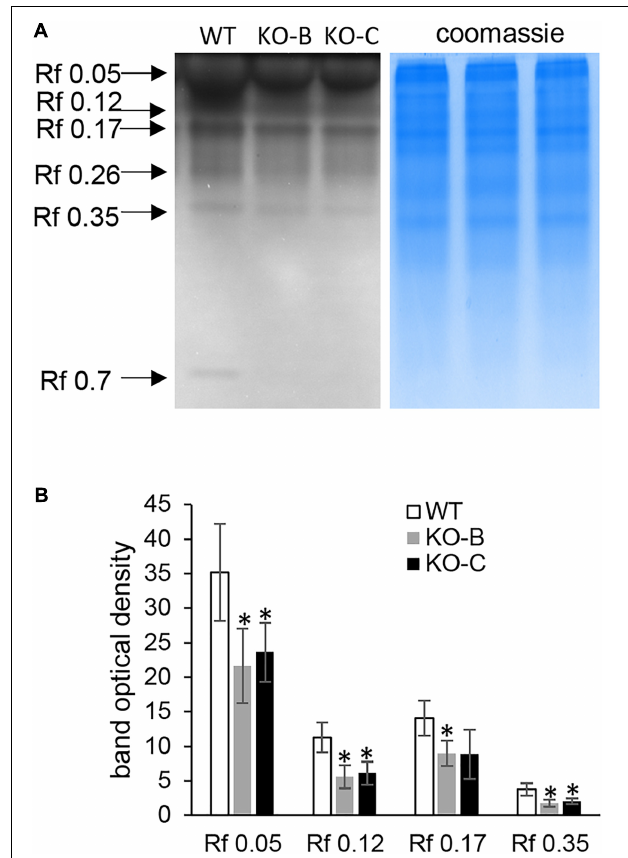
FIGURE 5 | Examination of chitinase activity in roots of wild type (WT) and HvMPK3 KO lines (KO-B and KO-C). (A) chitinase activity on native PAGE gels. Arrows indicate chitinase isozymes with designated relative mobility (Rf). Right panel: visualization of proteins on gel in A by Coomassie staining. (B) Quantification of band intensities in (A) . Asterisks indicate statistically significant differences between WT and HvMPK3 KO lines; ∗ p < 0.05, Student’s t -test. Uncropped, full original image of the gel is documented in Supplementary Figure 9A